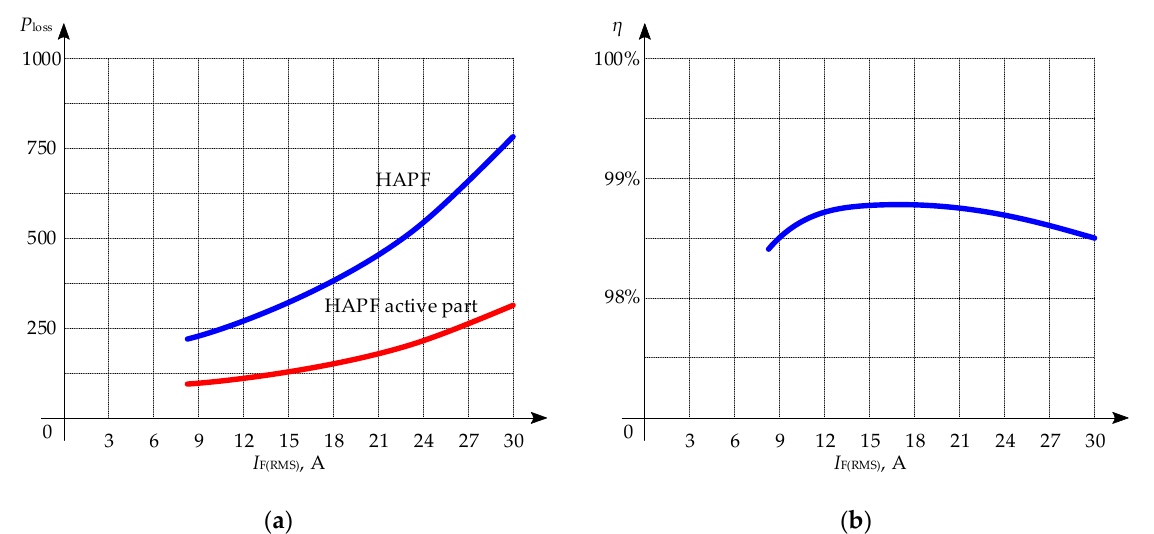
Figure 22. Measurement results of HAPF power characteristics given as a function of the RMS value of the filter current: ( a ) power losses of the active and passive part of HAPF; ( b ) the efficiency of the HAPF.